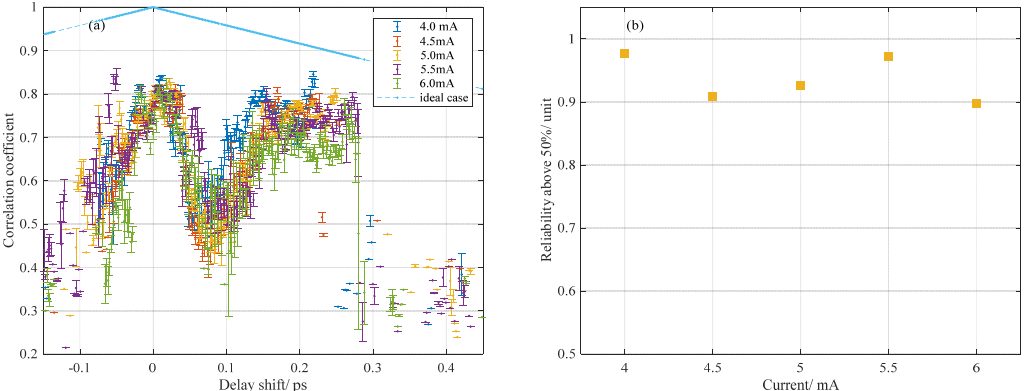
Figure 10. ( a ) Coefficient varied with maximum delay shift and ( b ) percentage of coefficients above 50%.